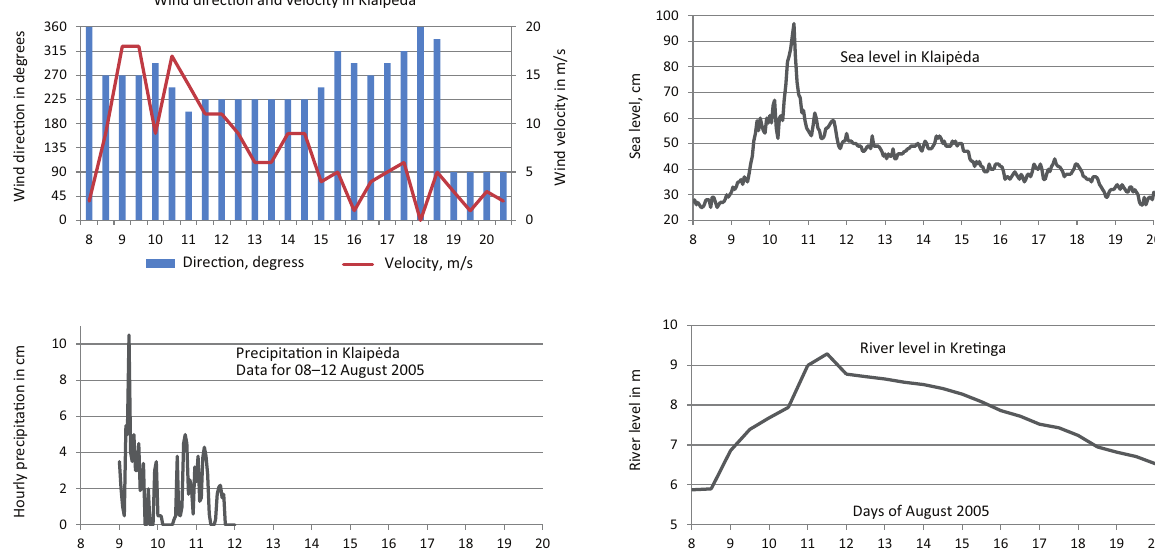
Fig. 4. Sequence of hydrometeorological factors resulting in the surge level appearance in the Akmena-Danė River, given by August days of